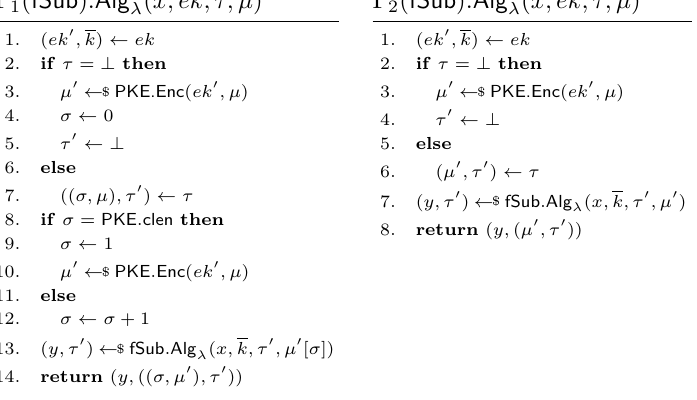
Figure 16: Definitions of Γ 1 and Γ 2 , our transformations on flexible symmetric ASAs to obtain flexible asymmetric